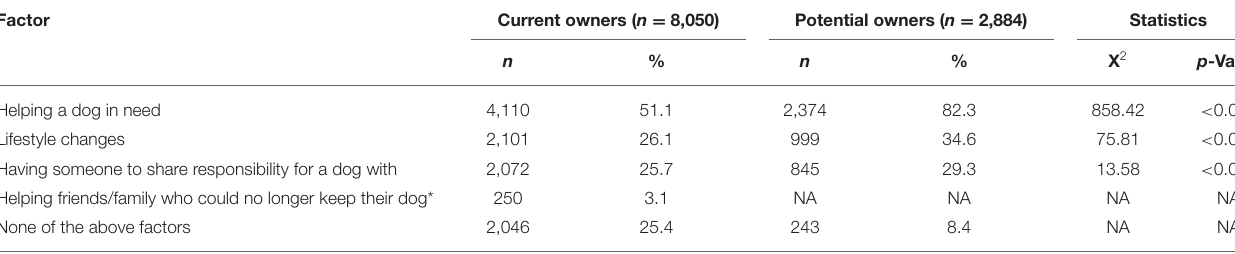
TABLE 3 | Factors when deciding to get a dog.